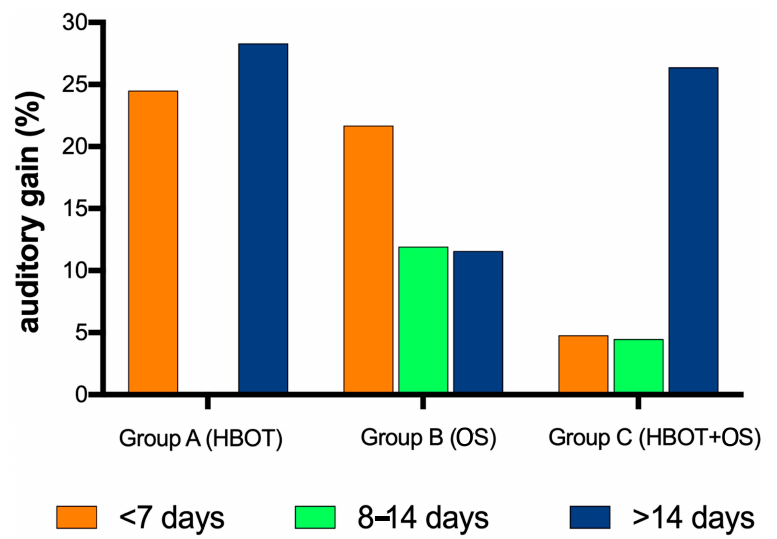
Figure 3. The graph shows the differences in the recovery at different time points among the three groups. HBOT and HBOT + OS allow to improve the hearing functions even after more than 15 days from the hearing loss onset. from the hearing loss